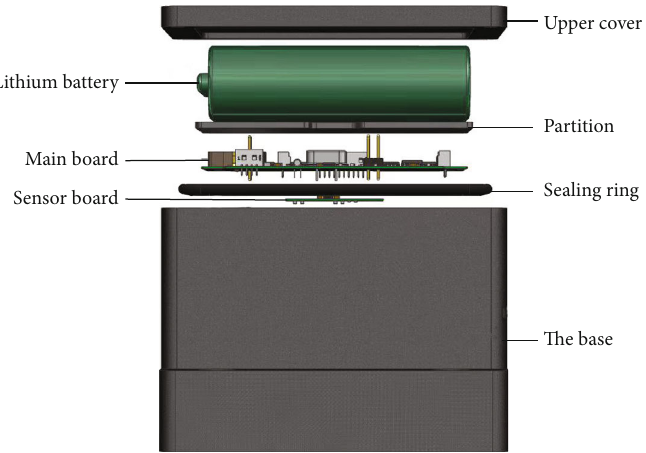
Figure 2: Mechanical appearance e ff ect diagram.